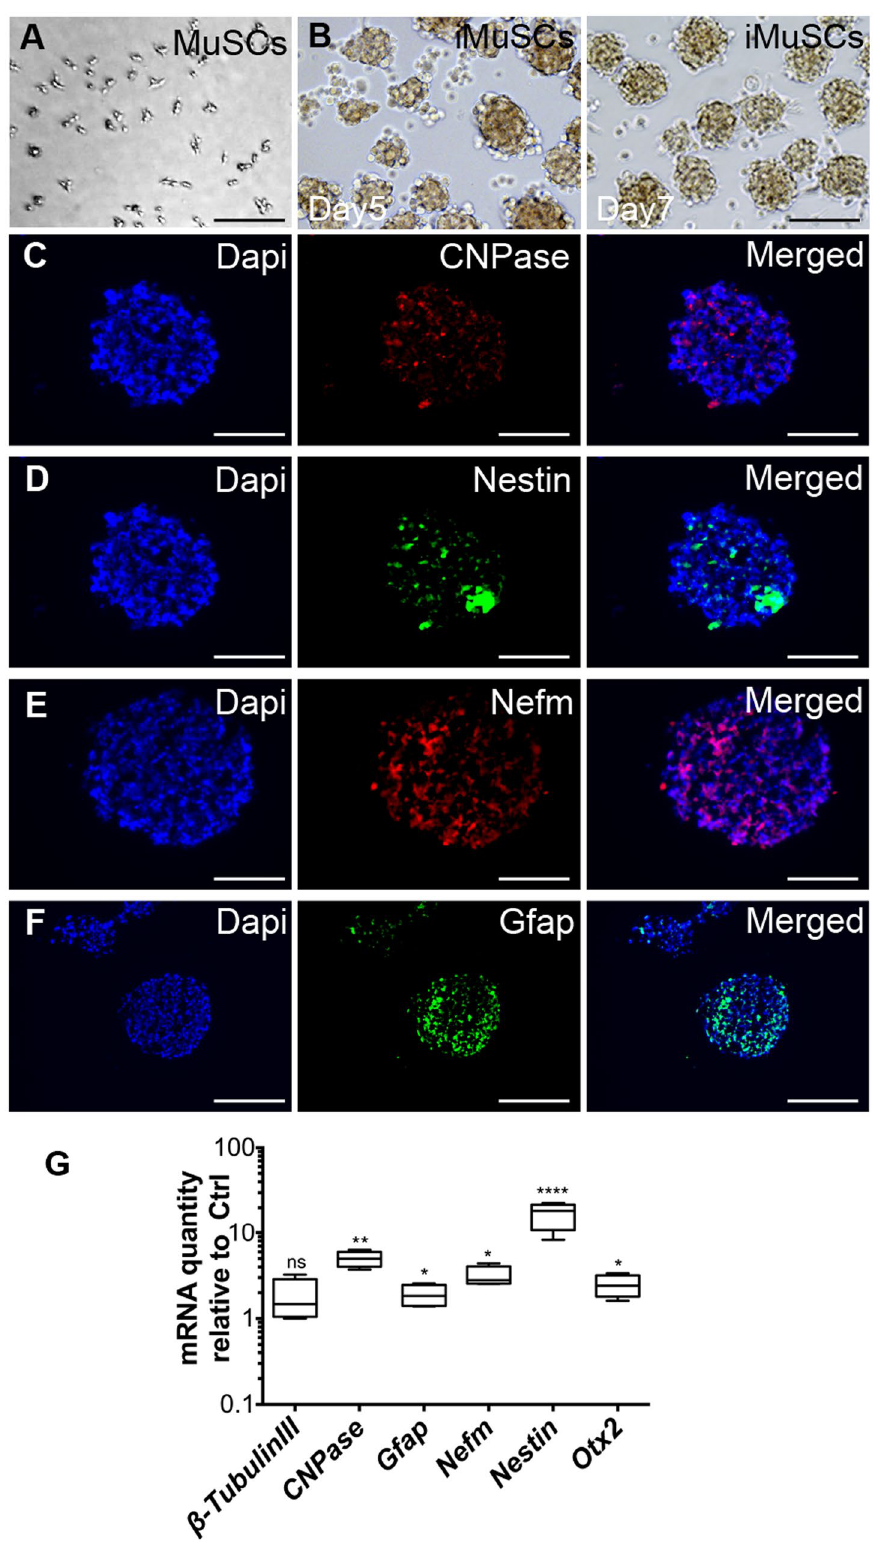
Figure 2. Neurosphere formation of iMuSCs. ( A ) BF image of the control MuSCs that could not form neurospheres. ( B ) BF image of the iMuSC-formed neurospheres in suspension. ( C–F ) Immunofluorescence images of cryosectioned neurospheres after 7 days of culture. They stained positive for CNPase (red, C ), Nestin (green, D ), Nefm (red, E ), and Gfap (green, F ). Nuclei were stained with DAPI (blue). Scale bar = 100 µ m. ( F) Whisker plots summarize the gene expression profiles of five biological replicates of iMuSC-formed neurospheres after 7 days of culture compared to undifferentiated iMuSCs by